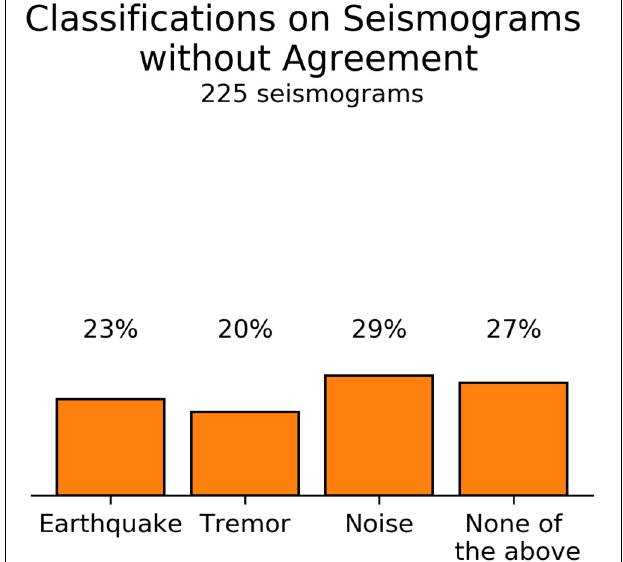
FIGURE 5 | Histograms for classifications made on seismograms without conclusive label. The seismograms contained in this category have received the same amount of classifications for at least two different categories with less classifications for the other categories.